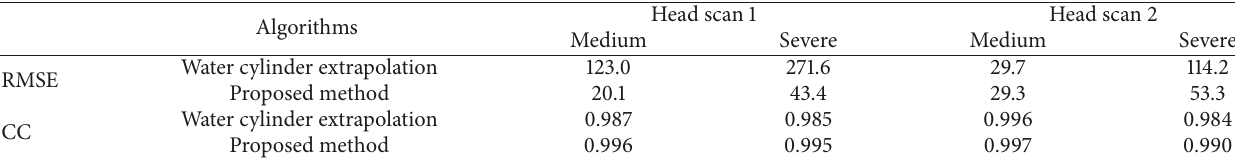
Table 1: Summary of quantitative evaluation of truncation correction methods for medium truncation (ROI: radius of 95 pixels) and severe truncation (ROI: radius of 60 pixels).